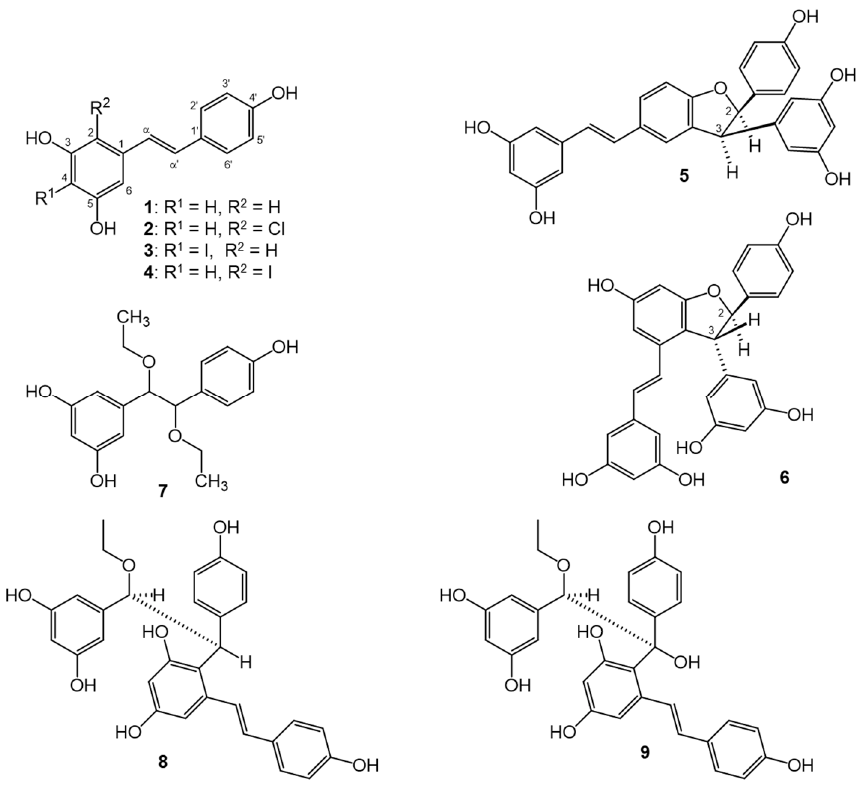
Figure 1. Structures of resveratrol ( 1 ) and its metabolites obtained by chemical oxidation ( 2–9 ). Each optically active compound ( 5 , 6 , 8 , 9 ) is racemate; for simplicity, only one enantiomer is presented. For compounds 7 and 9 , the relative configuration could not be determined.